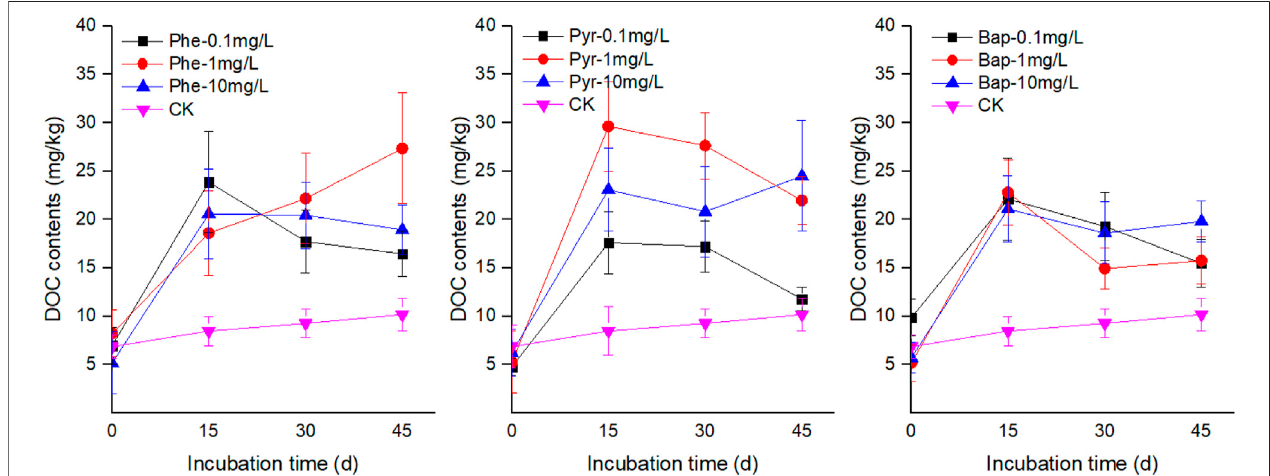
FIGURE 1 | Effect of PAH stress on the amounts of DOC excreted by B. gymnorrhiza.